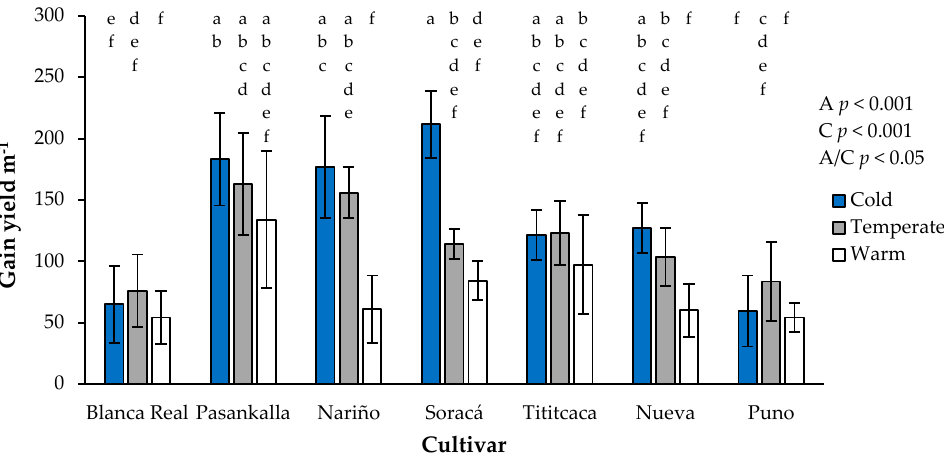
Figure 4. Grain yield of different quinoa cultivars subjected to three altitude gradients. The bars indicate standard error. Different letters indicate significant differences. A: Altitudinal; C: Cultivar; A/C: Altitudinal/Cultivar.